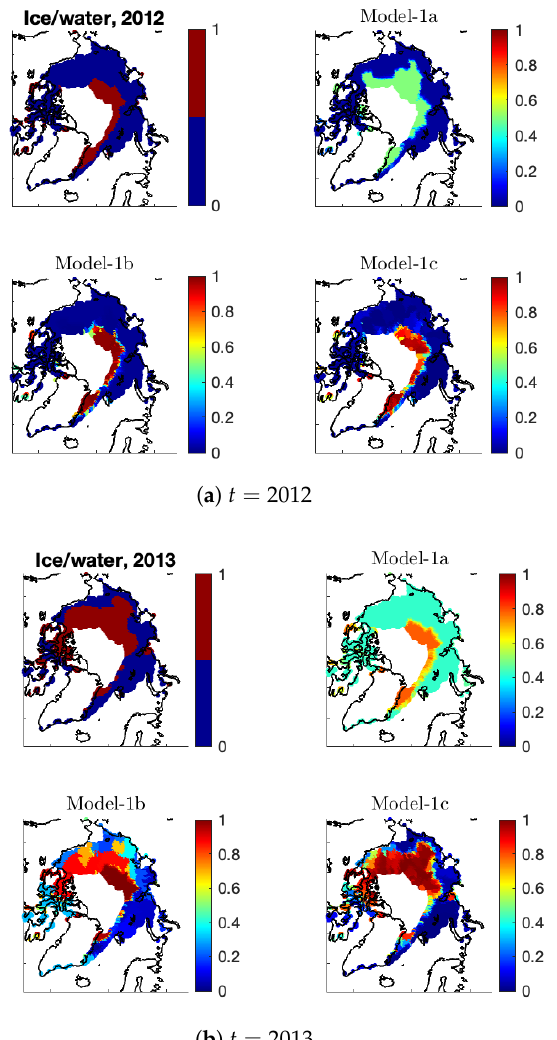
Figure A2. For each of ( a ) t = 2012 and ( b ) t = 2013, shown are the observed ice/water statuses ( upper-left panel ) and the estimated ice probabilities by Model-1a ( upper-right panel ), Model-1b ( lower-left panel ), and Model-1c ( lower-right panel